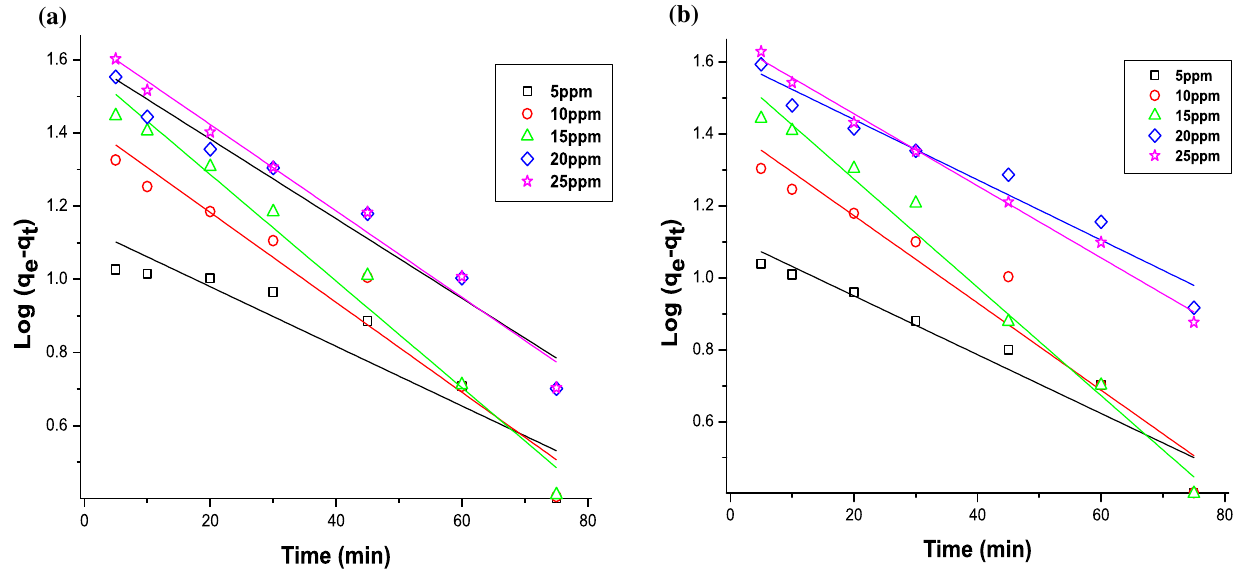
Fig. 15 Pseudo-first-order kinetic model for a KOHAWS1 and b